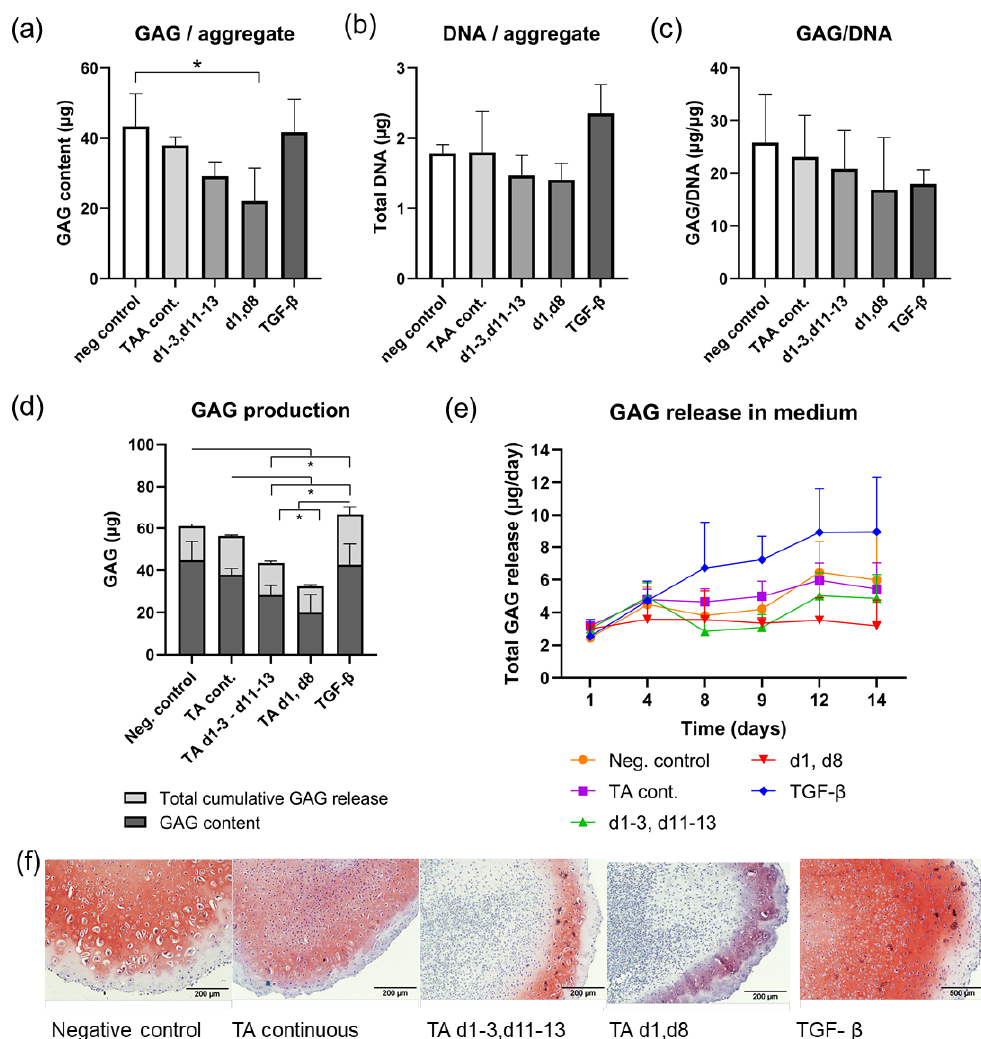
Figure 4. Biochemical and histological analysis of aggregates exposed to continuous or intermittent TA. ( a ) Total GAG per aggregate was significantly lower in the condition that received TA on day 1 and 8 compared to the negative control of the 14-day experiment. ( b ) DNA per aggregate and ( c ) GAG/DNA did not differ between culture conditions after the 14-day culture experiment. ( d ) Total GAG production and GAG release and ( e ) GAG release in the culture medium showed a similar pattern, in which total GAG production and release were significantly lower in the conditions that received TA intermittently (TA d1–3, d11–13 and TA d1,d8) compared to the other conditions. ( f ) Safranin-O/Fast Green staining of representative aggregate paraffin sections. * indicates significant difference ( p < 0.05).